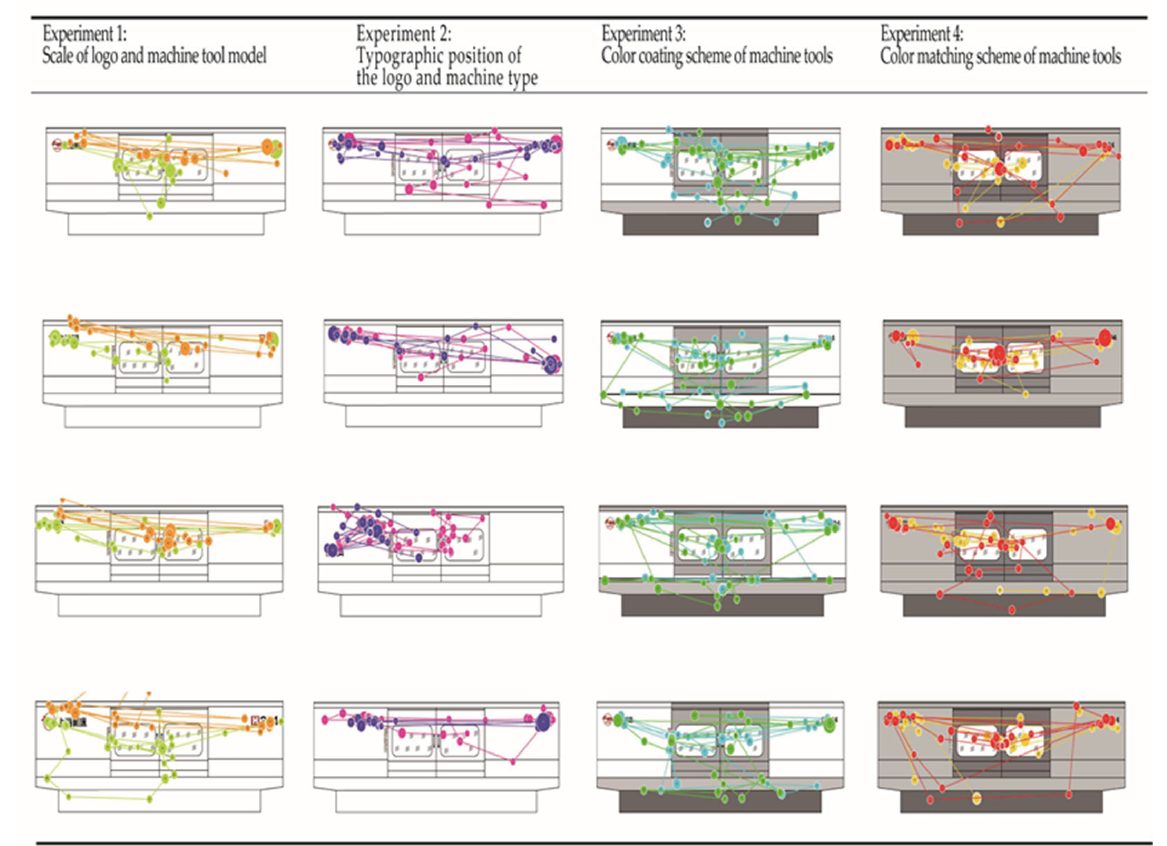
Figure 5. Illustration of user’s sight trajectory.